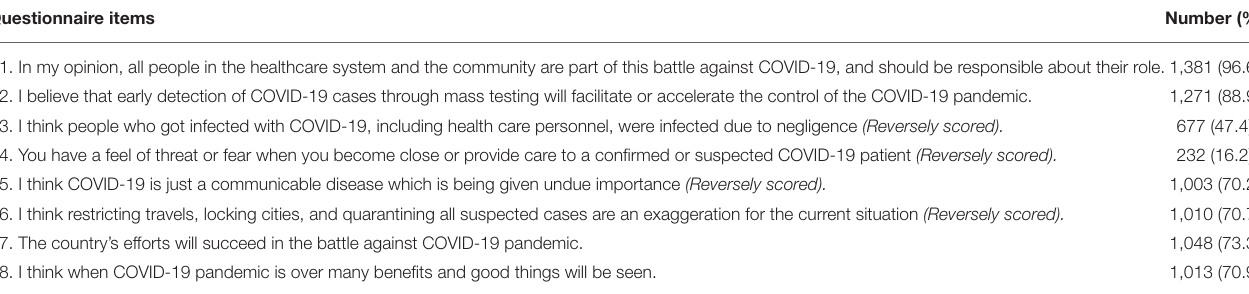
TABLE 3 | Frequency and percentage of the participants with positive responses to the attitude items on the